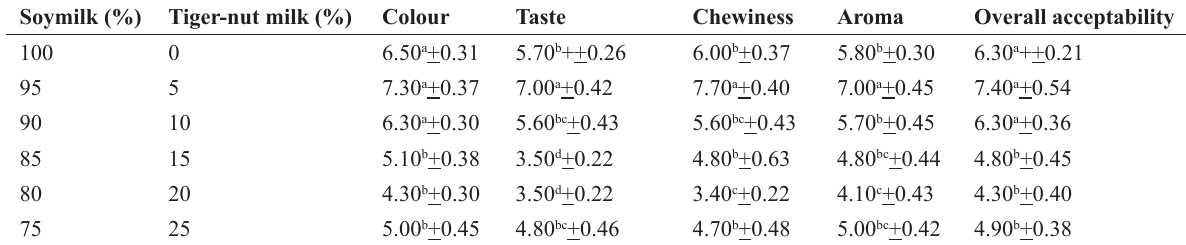
Mean ± SD. Means with same superscripts are not significantly different (p≤0.05) Table 5: Mean scores soymilk-tiger nut milk cheese blend. Soymilk (%) Tiger-nut milk